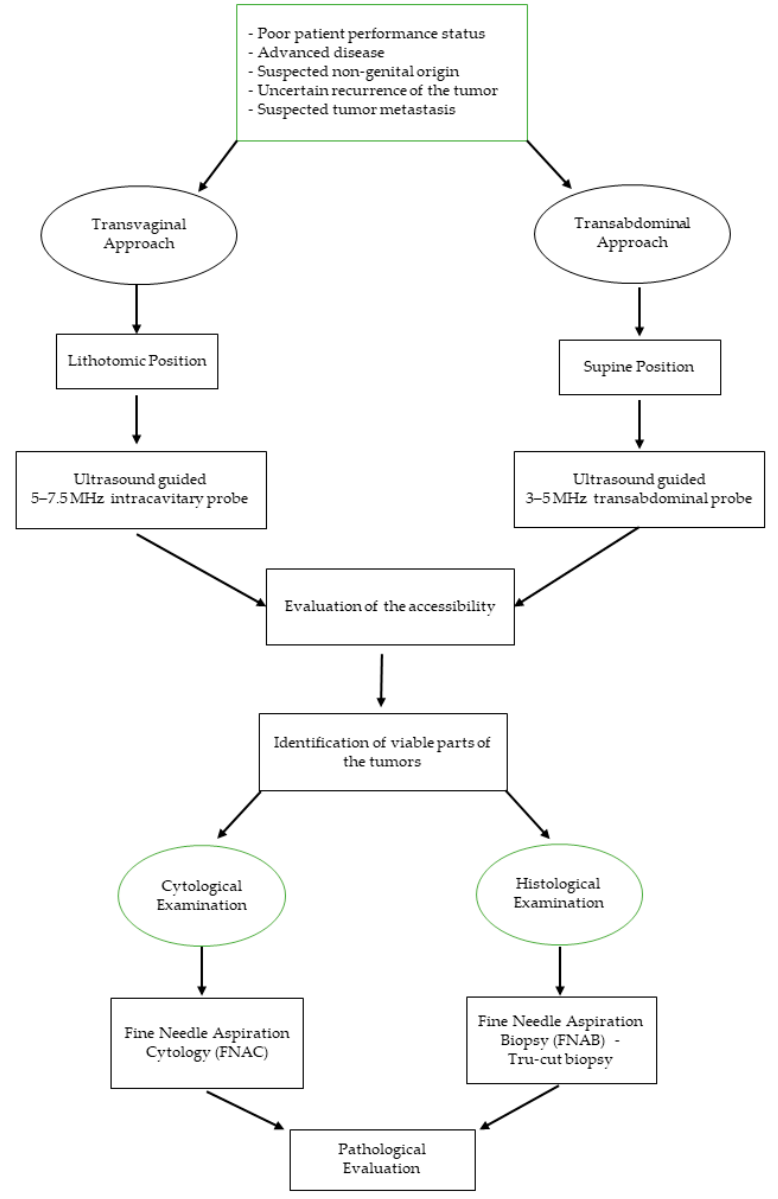
Figure 1. Flowchart on how to utilize ultrasound-guided sampling of pelvic masses.